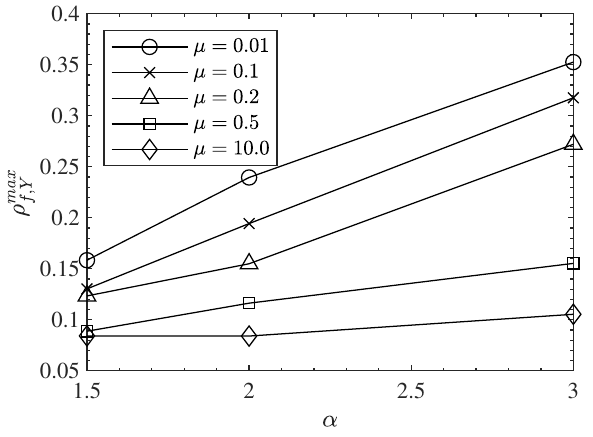
Figure 3. The maximum correlation coe ffi cient, ρ max for di ff erent intergranular friction µ , with interpolating lines to guide the